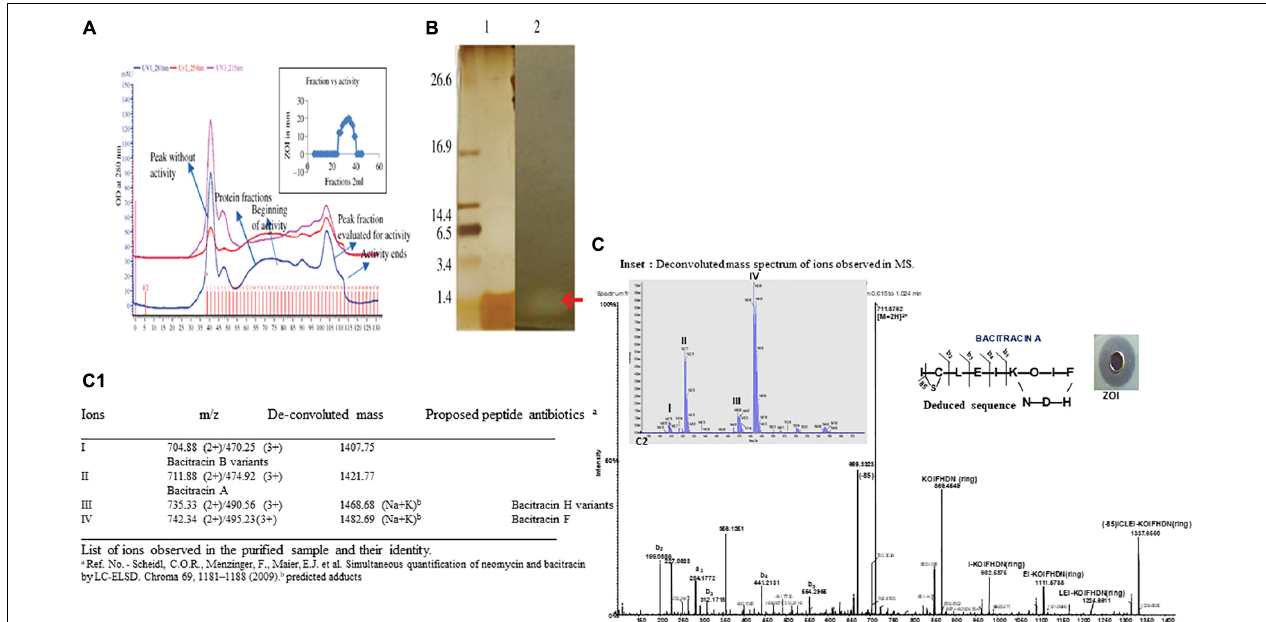
FIGURE 2 | (A) Elution profile and activity profile of the BAMP-purified fraction. The antimicrobial activity of the fractions is showed in the inset. (B) Tricine-SDS-PAGE of purified BAMP. Lane 1: marker; lane 2: purified BAMP; lane 3: direct overlay of tricine-SDS-PAGE gel demonstrating ZOI indicating the activity of purified BAMP. (C) MS-MS spectrum of purified BAMP (inset) showing the well-diffusion assay/ZOI. (a) LC-MS profile of active fraction of antimicrobial compound of BAMP. Assignment of b and y ions. Amino acid sequence deduced from the MSMS data. The inset shows the deconvoluted mass spectrum of peaks I, II, III, and IV and were observed and demarcated. (C1) The List of ions observed in the purified sample and their identity.